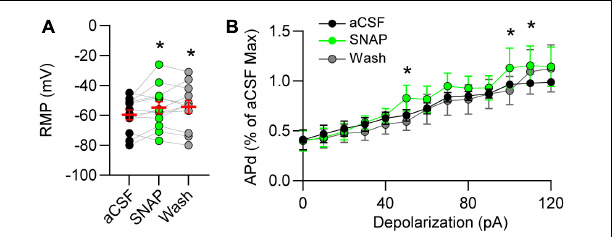
FIGURE 5 | Gamma-aminobutyric acid transporter 3 influences membrane potential and discharge. (A) Resting membrane potential (RMP) depolarized in GAT-3 block. RM one-way ANOVA with LSD post hoc : F (2,22) = 3.543, * p ≤ 0.05 vs aCSF. (B) Action potential discharge (APd) evoked via current depolarization. Data plotted to maximum discharge of aCSF baseline (denoted as “1” at 120 pA injection). Note GAT-3 inhibition increased discharge at the higher current injection. Two-way RM ANOVA; pA main factor, F (12,120) = 32.08, p ≤ 0.001; drug main factor, F (1,10) = 0.8105, p = 0.38; interaction, F (12,120) = 0.8703, p = 0.57. * p ≤ 0.05 vs aCSF. Data in A shown as individual neurons (connected circles), their responses, and means ± SEM in